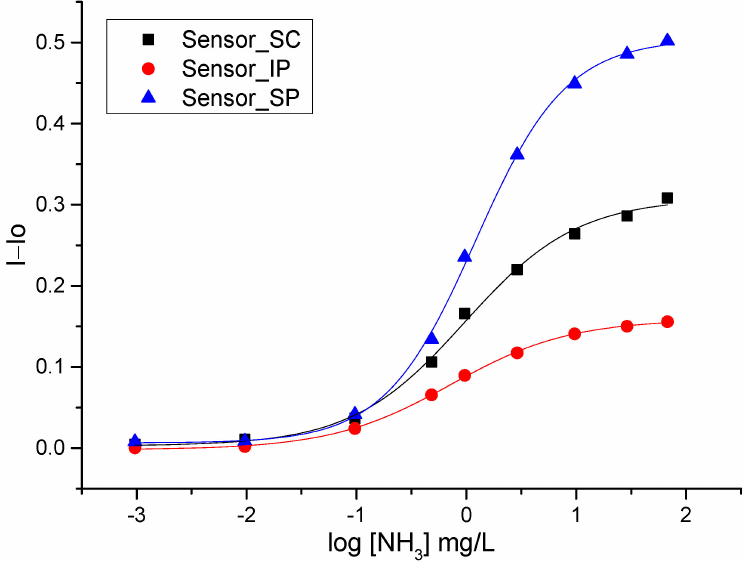
Figure 6. Calibration curves for optical sensor layers (SC, IP, SP) in the presence of dissolved NH 3 in the concentration range 1.0 × 10 − 5 M–7.0 × 10 − 1